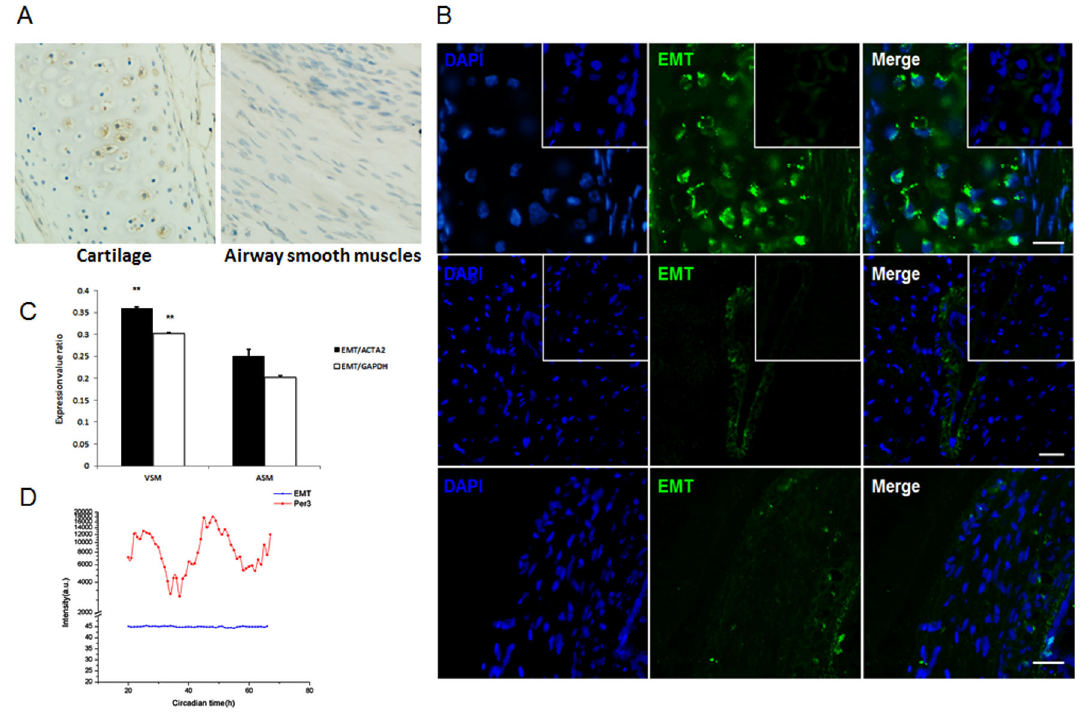
Figure 2. The expression prolife of EMT. A , immunohistochemical staining showed the expression of EMT in chondrocytes of tracheal cartilage, but not in airway smooth muscles. B , immunofluorescent labeling of EMT on chondrocytes (upper three subpanels), coronary smooth muscle cells (middle three subpanels) and airway smooth muscle cells (lower three subpanels). Specificity of EMT-immunolabeling was documented by antibody preabsorption (insets in upper and middle subpanels). The nuclei were stained blue with DAPI, and EMT was stained green by the immunofluoresence method. Scale bar: 20 μm. C , comparison of EMT expression in human airway smooth muscle (ASM) cells and vascular smooth muscle (VSM) cells. Data were extracted from open-access microarray datasets (GEO accession GSE2883, GSE13168). The expression values were normalized to GAPDH or ACTA2 in each dataset, ** p <0.001. D , the circadian transcription patterns of EMT and Per3. Note that Per3 (a typical circadian gene) showed circadian fluctuation in transcription, while EMT transcription did not show circadian fluctuation. Data were extracted from an open-access microarray dataset (GEO accession GSE 11922).